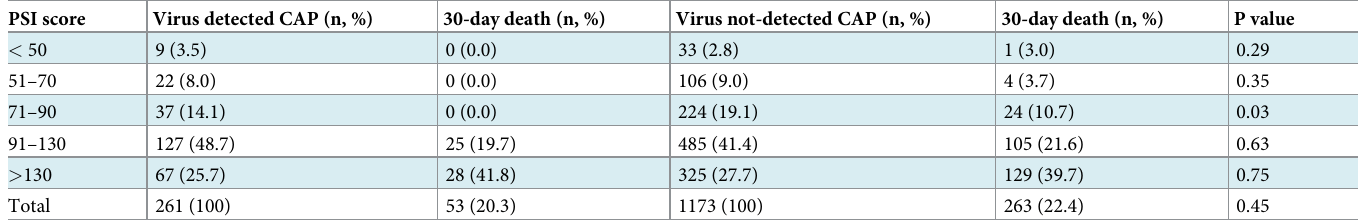
Table 2. Thirty-day mortality based on pneumonia severity index between virus detected CAP and virus non-detected